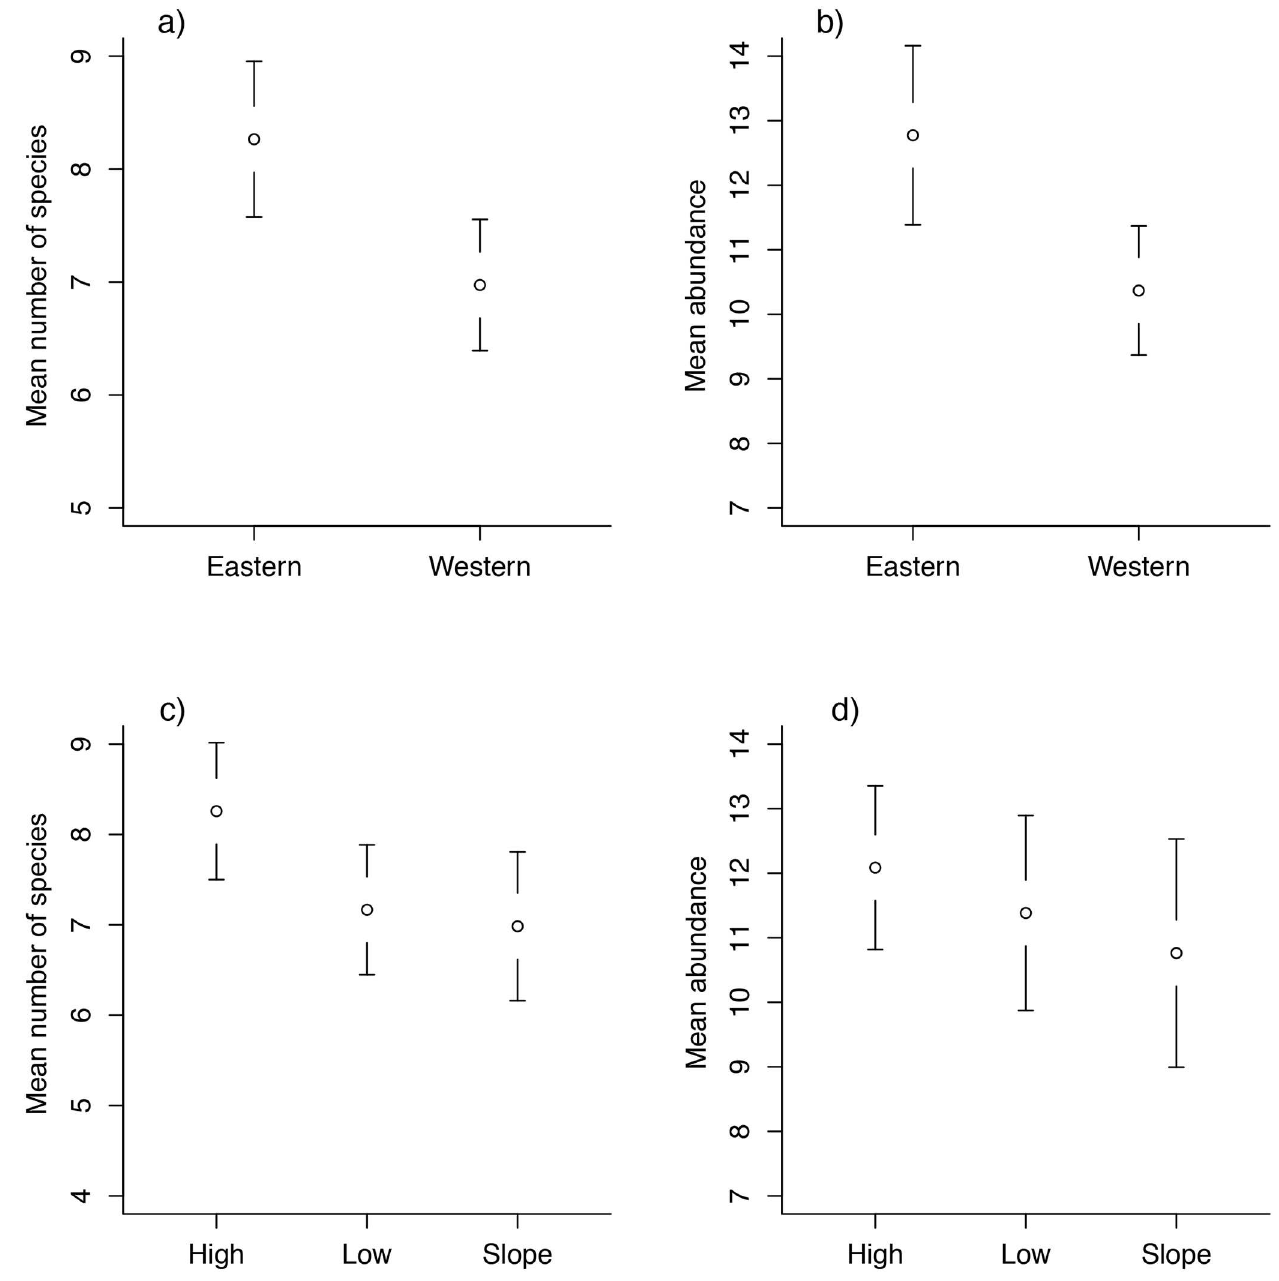
Fig 2. Number of species and abundance of birds vs. environmental groups and watersheds. Mean number of speciescaptured per plot or mean abundance in different watersheds(a and b, respectively)and in different environmental groups(c and d, respectively). Bars indicate 95%